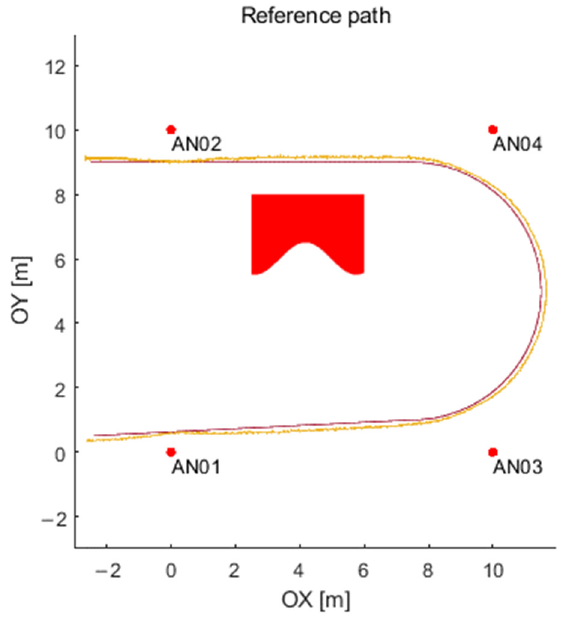
Figure 21. Path calculated (by trilateration algorithm) using generated distances.